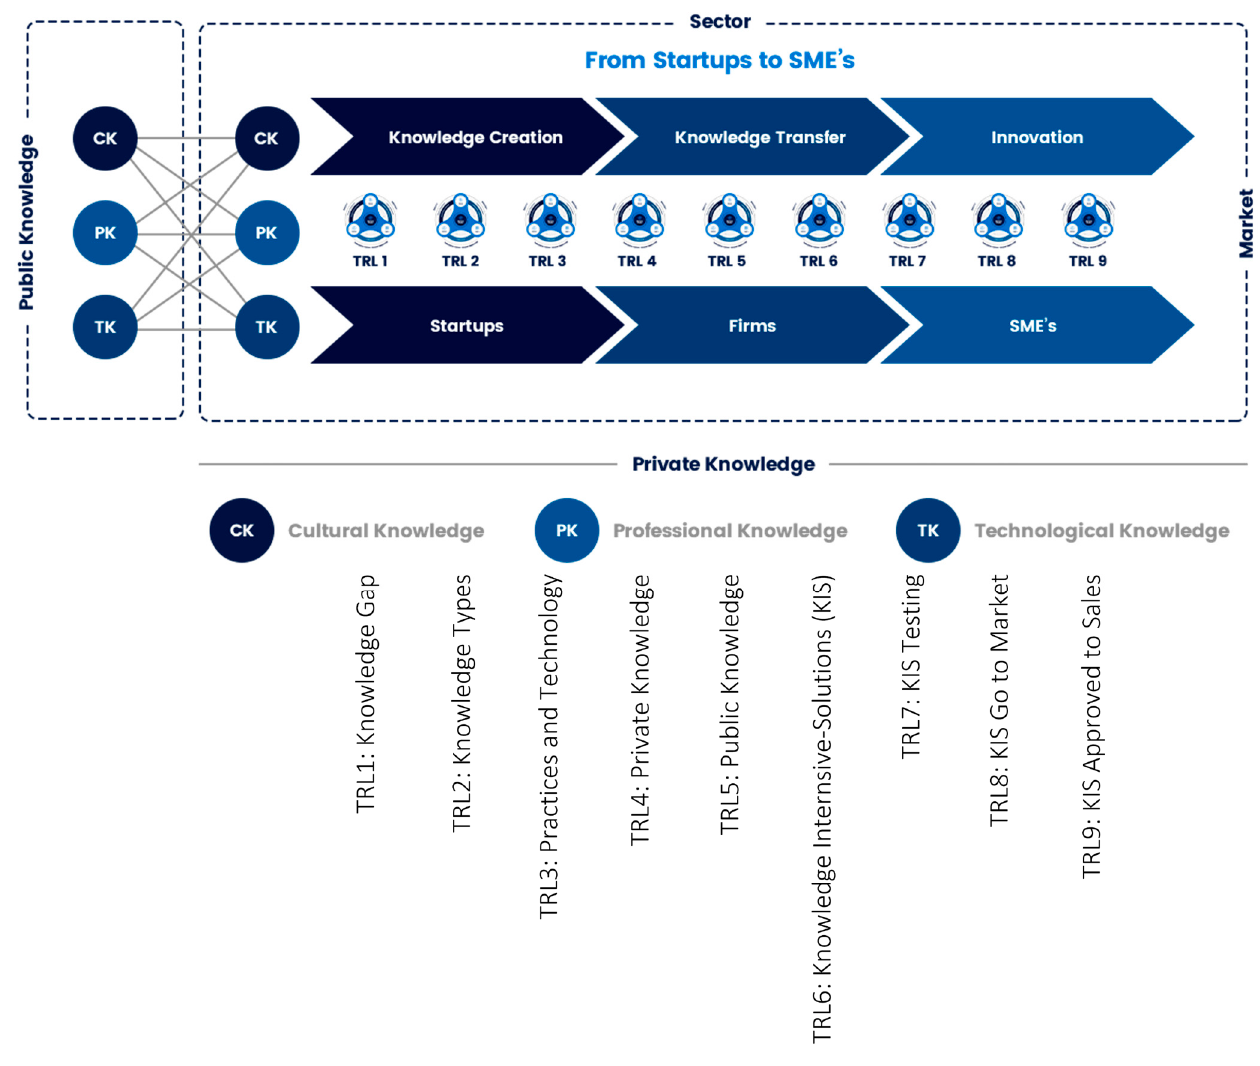
Figure 3. The Spinner Knowledge Flow in Support of Triple Helix Model